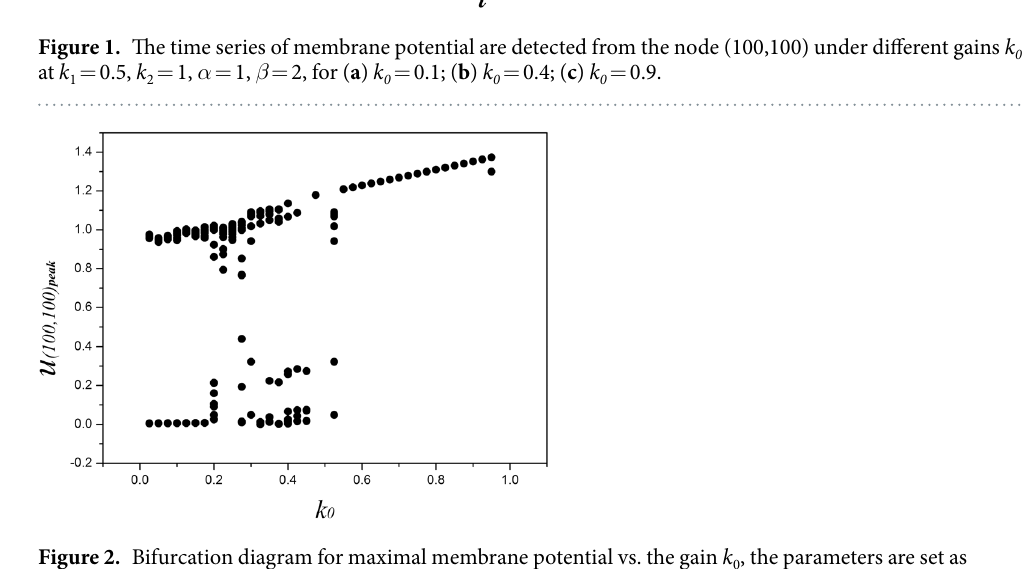
Figure 2. Bifurcation diagram for maximal membrane potential vs. the gain k 0 , the parameters are set as k 1 = 0.5, k 2 = 1, α = 1, β = 2. Within the sampled time series for membrane potential for node (100, 100), the peak value for membrane potential is recorded only when the membrane potential is beyond the values for the pre-adjacent and post-adjacent